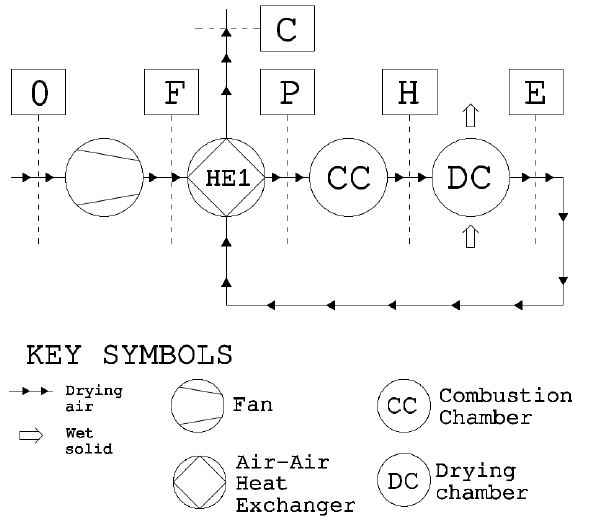
Figure 7. Scenario 1 is the first upgrade of the baseline scenario: An open cycle installed with a heat recovery